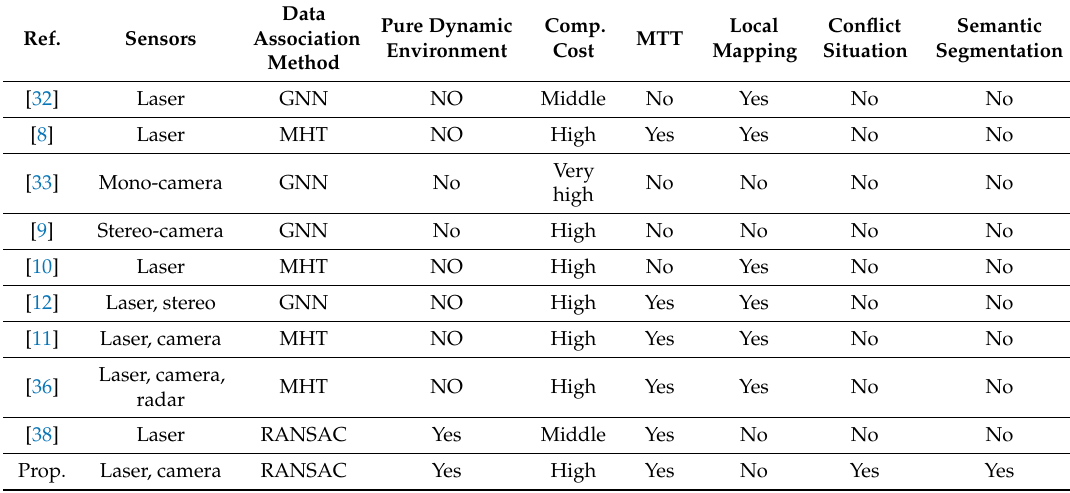
Table 1. A qualification comparison among the Simultaneous Localization and Mapping (SLAM) algorithms for dynamic